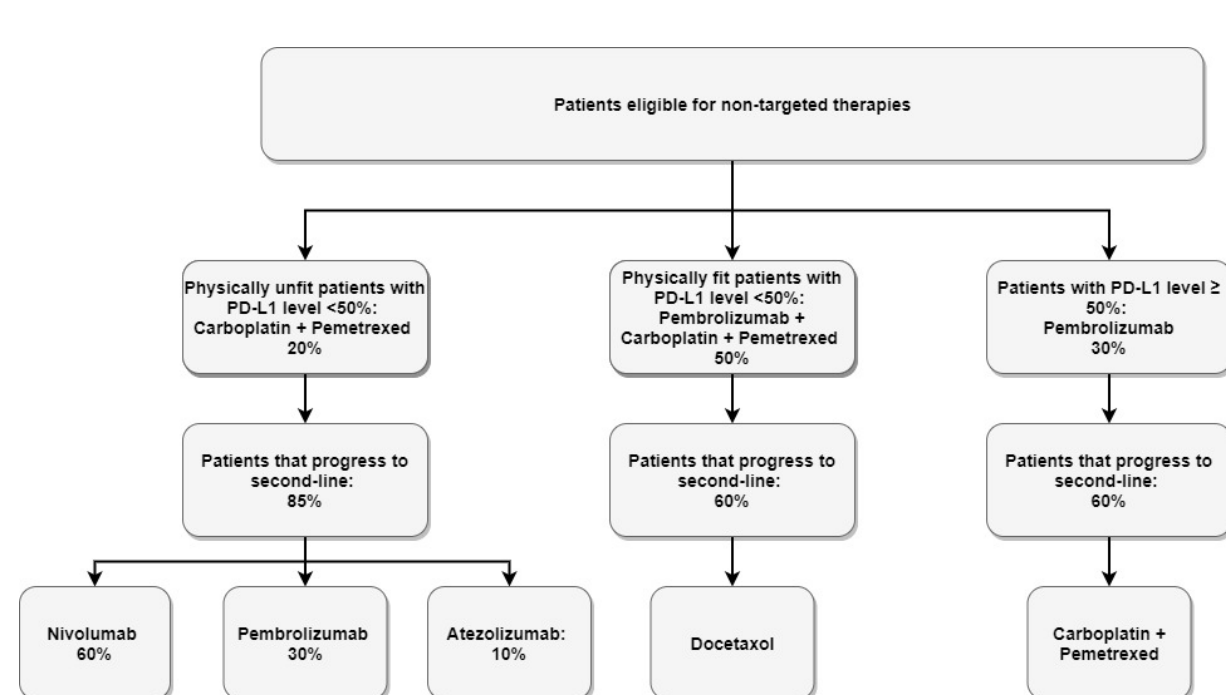
Figure 4. Treatment distribution: non-targeted therapies. Table 3. ( a ) Treatment distribution—reference scenario. ( b ) Treatment distribution—new scenario. (a) Treatment Distribution—Reference Scenario